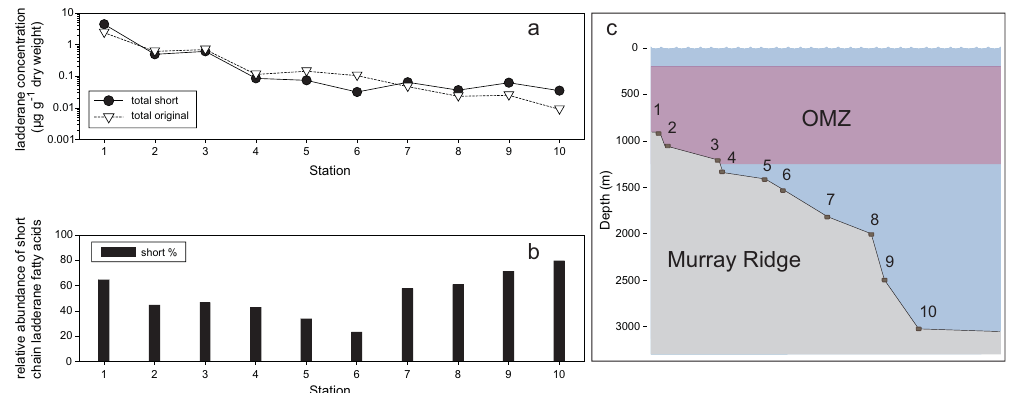
Fig. 5. (a) The concentrations (original: open triangles; short chain: filled circles) of ladderane fatty acids and (b) proportion of short chain ladderane fatty acids in surface sediment along the Murray Ridge (c) , Stations 1–10 in the Arabian Sea collected during R/V Pelagia cruise 64PE301. Note the log scale in